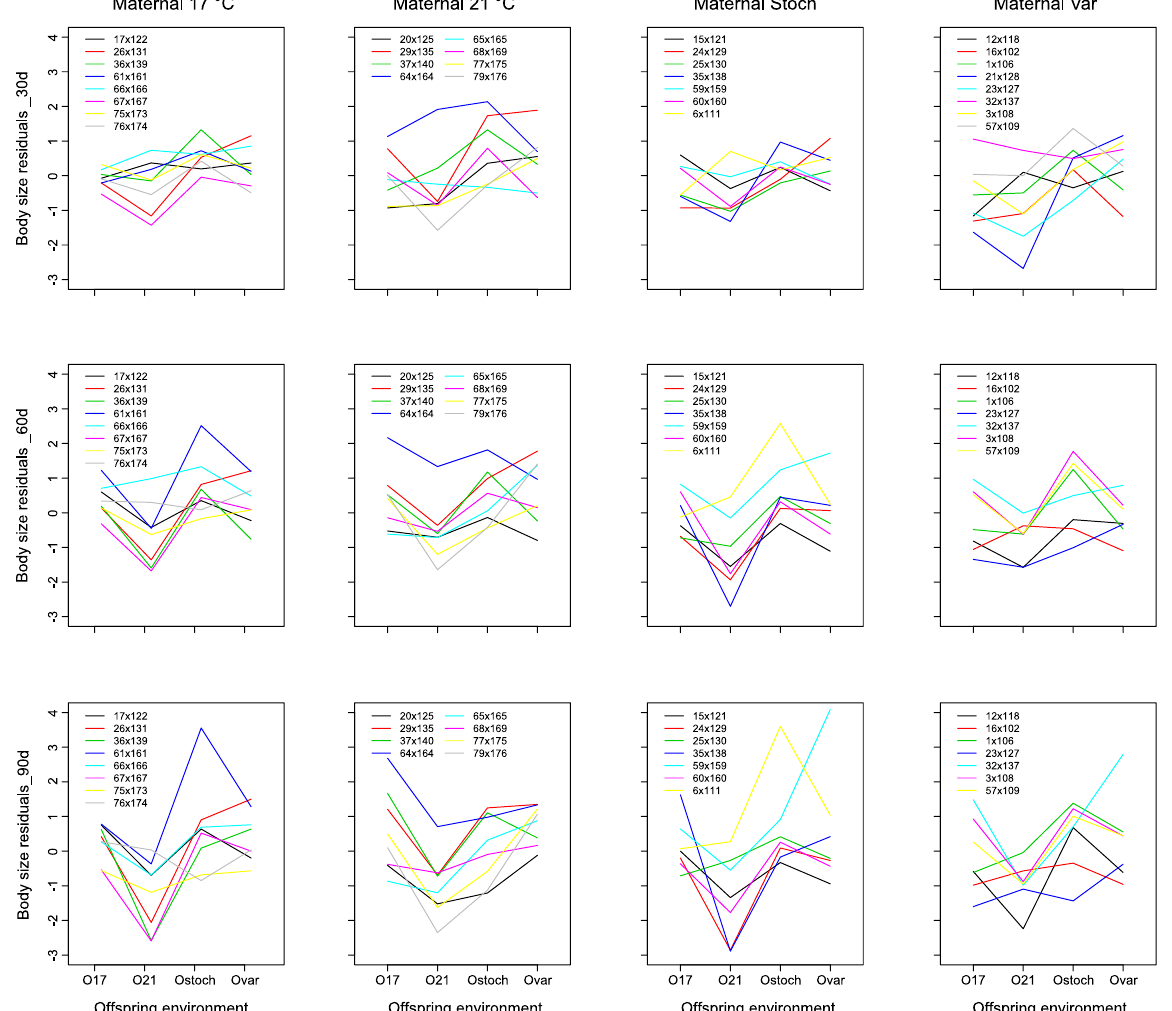
Figure 3. Family reaction norms of body size residuals (standard length (mm) corrected for density) of stickleback ( Gasterosteus aculeatus ) offspring at 30, 60, and 90 d post-hatch in the four maternal acclimation environments (four panels) and offspring rearing temperature environments (constant 17 °C, constant 21 C, predictably variable, and stochastically variable). Family names are shown as sire × dam identification numbers; lines join offspring rearing